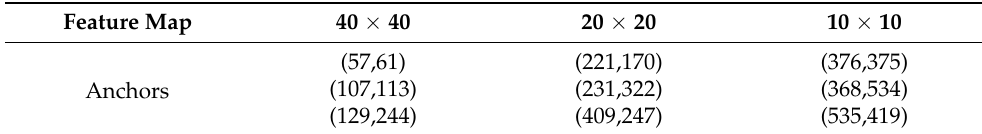
Table 3. Anchor box matching.